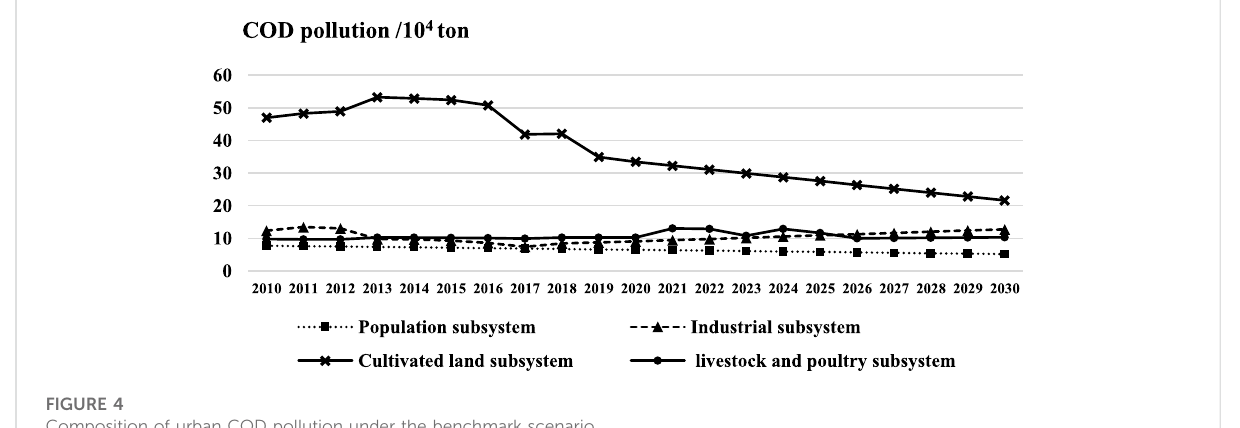
Composition of urban COD pollution under the benchmark